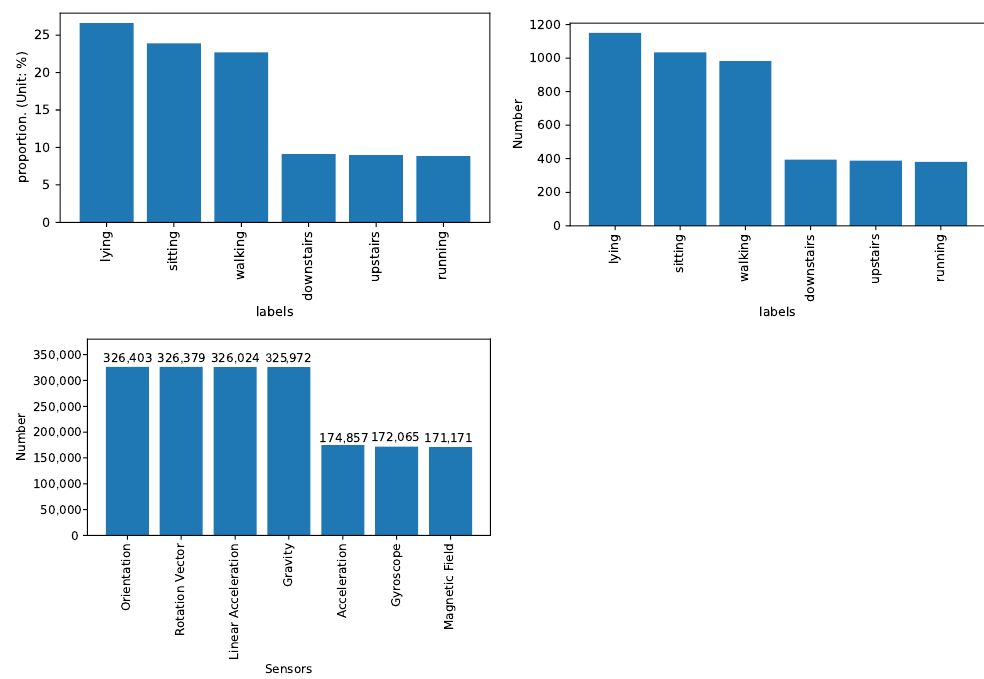
Figure 10. Proportion and number of different labels. Furthermore, the number of each sensor readings